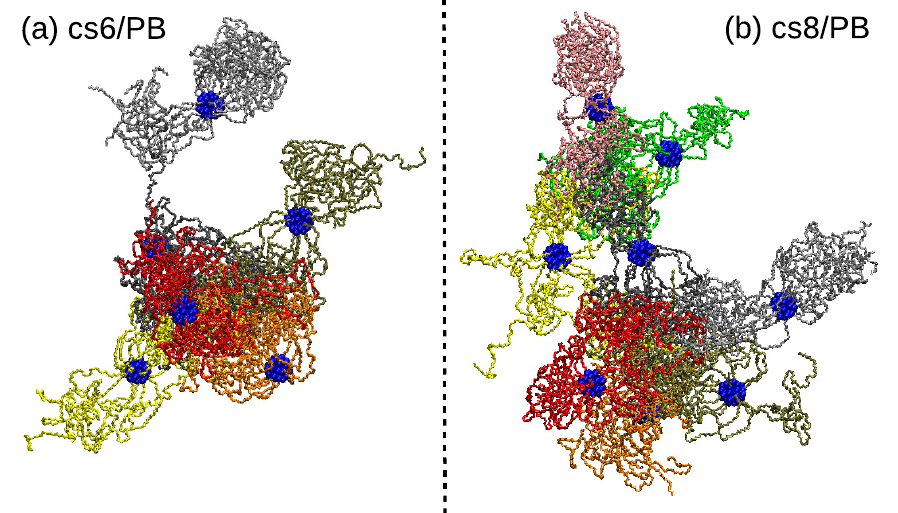
Figure 10. Randomly selected snapshots of the PEO domains aggregated in the assembly in ( a ) cs6/PB, ( b ) cs8/PB system prepared by the “assembly-first” protocol. Domains belonging to different stars are painted with different colors, the central dendritic structure of each star is depicted with blue